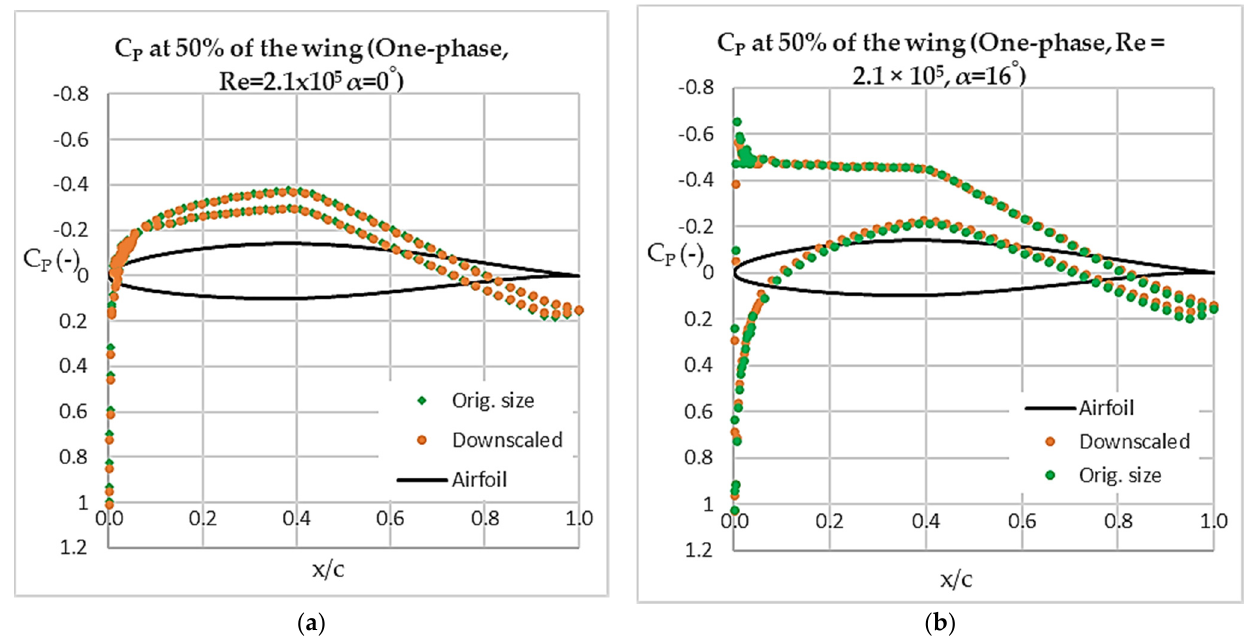
Figure 11. Coefficient of pressure distribution around airfoil at 50% of the wingspan, in one-phase flow: ( a ) AoA = 0°; ( b ) AoA = 16°.